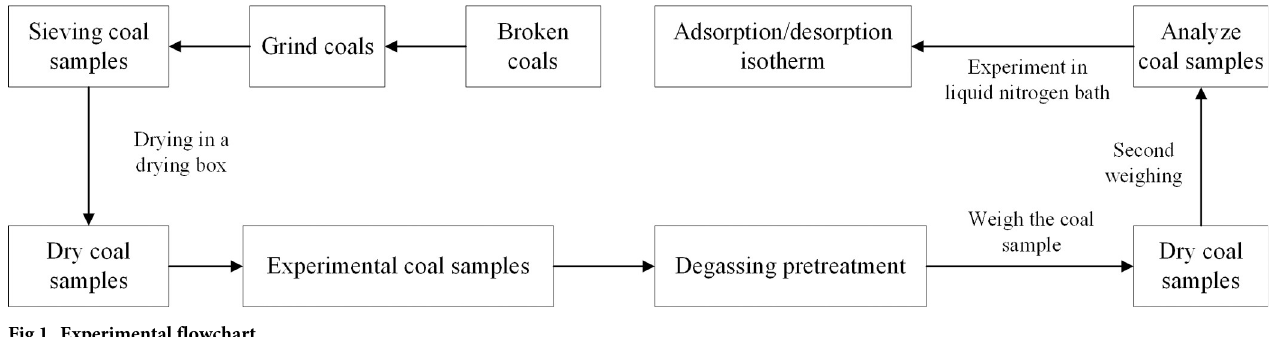
Fig 1. Experimental